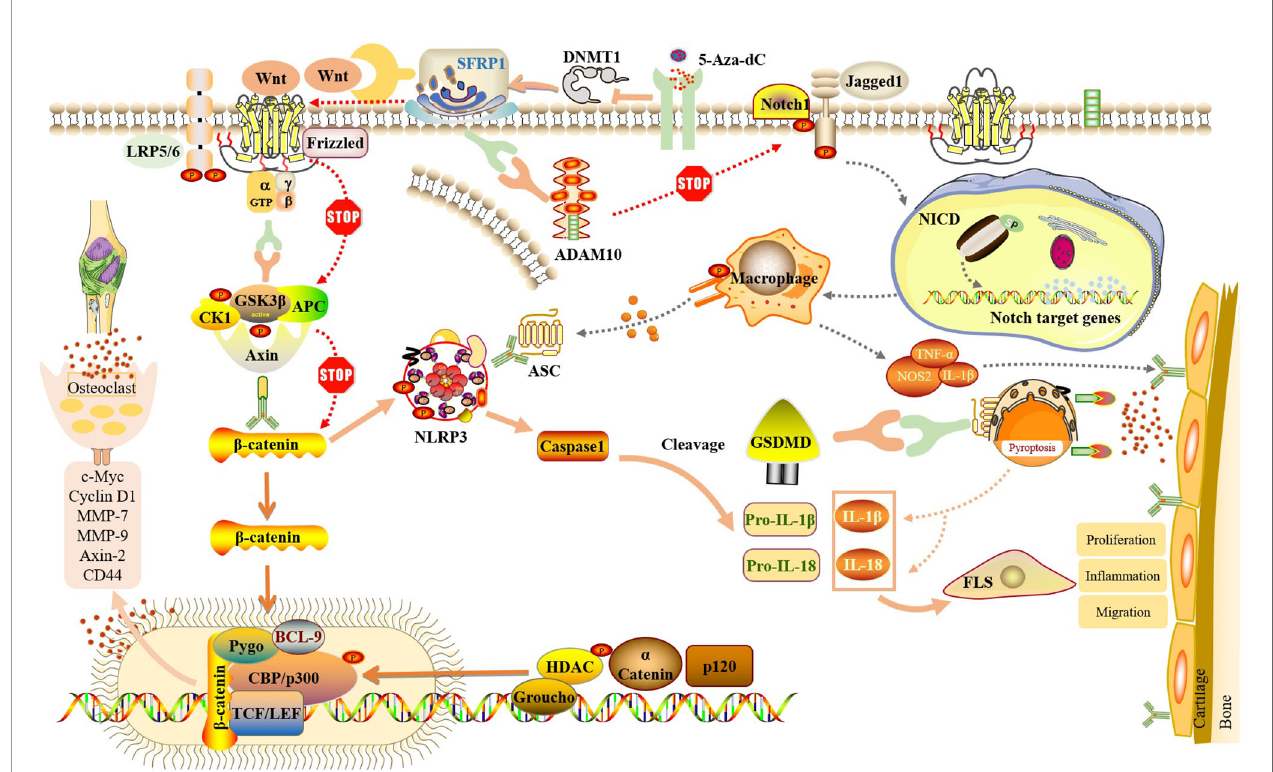
FIGURE 4 | SFRP1 participate in NLRP3-mediated cell pyroptosis by regulating the dual signaling pathways of Wnt/ b -catenin and Notch. By binding to Wnt protein and ADAM10 protein, SFRP1 negatively regulates Wnt/ b -catenin and Notch signaling, blocks the activation of downstream proteins and the release of in fl ammatory factors, and reduces the in fl ammatory response of FLS and the destruction of articular cartilage. And indirectly inhibit the activation of NLRP3 in fl ammasome and block the occurrence of cell pyroptosis. Methylation inhibitor of 5-Aza-dC could inhibit the expression of DNMT, release SFRP1 hypermethylation and up-regulate the expression of SFRP1 in RA-FLS, thus negatively regulating Wnt/ b -catenin and Notch signaling